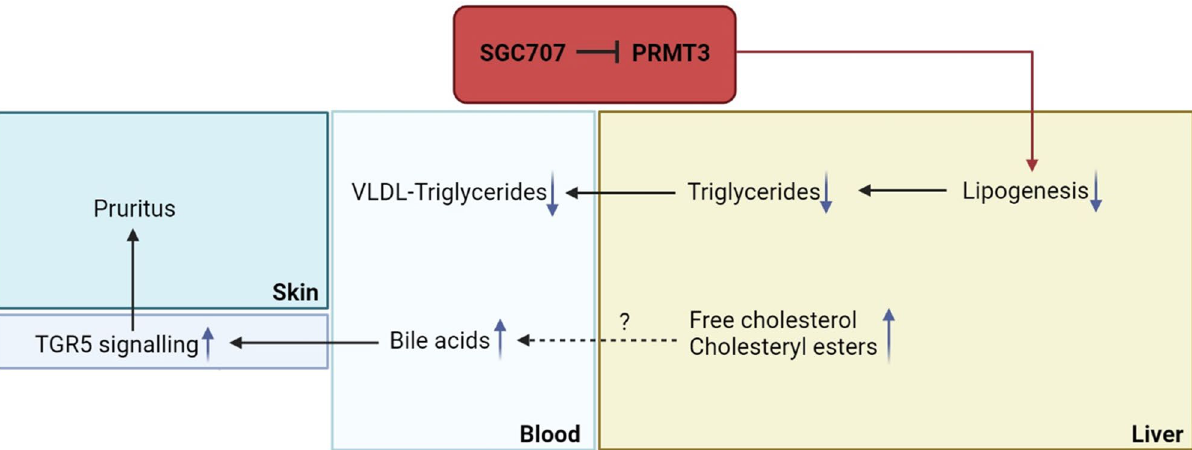
Figure 7. Schematic overview of the effect of PRMT3 inhibitor SGC707 treatment in LDL receptor knockout mice. Inhibition of the PRMT3 activity by SGC707 is associated with a decrease in transcript levels of gene involved in lipogenesis and a parallel reduction in hepatic triglyceride stores and plasma VLDL-triglyceride levels. Probably as result of decreased cholesterol elimination via VLDL particle secretion, livers of SGC707- treated mice accumulate free cholesterol and cholesteryl esters and generate more bile acids. The associated increase in the plasma bile acid pool coincides with enhanced systemic TGR5 activation, which can underlie the unexpected pruritus development in SGC707-treated